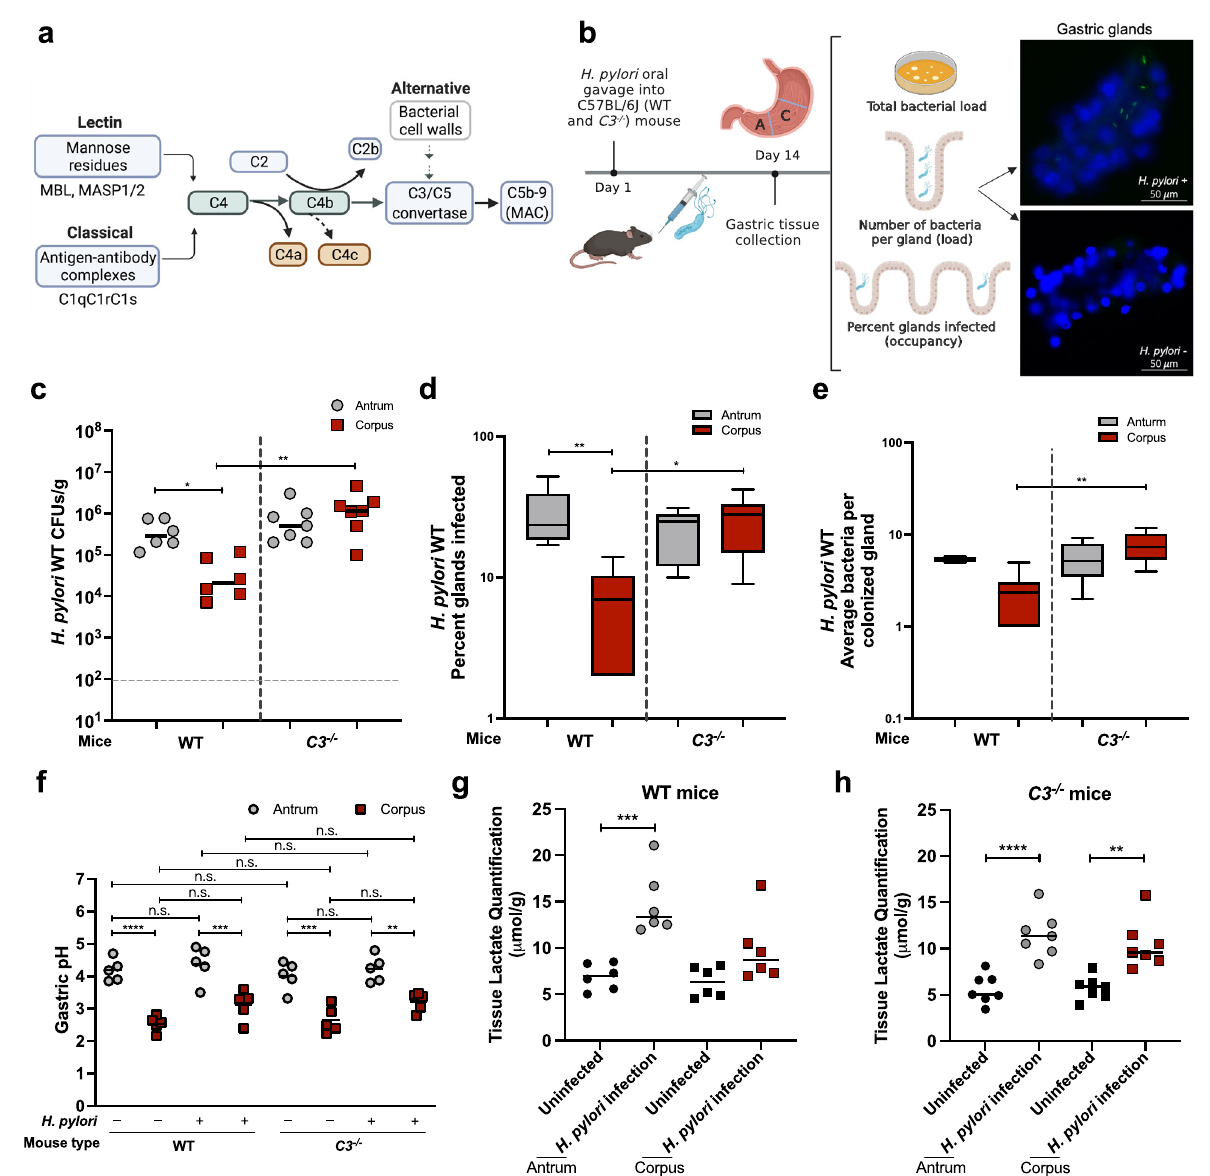
Fig. 1 | Complement plays a vital role in restricting H. pylori gastric coloniza- tion. a Schematic diagram of complement pathways activation. b Schematic illustration of mouse infection analysis. C57BL/6J WT ( n =6) or C3 − / − ( n =7) mice were infected by oral gavage with GFP + H. pylori PMSS1 for two weeks. Stomachs wereisolatedfrominfectedmiceandseparatedintocorpusandantrumpiecesand processed to obtain the total bacterial numbers (colony forming units, CFUs) by plating,toenumeratebacteriainglandsusingmicroscopy.Bacteriawerevisualized by GFP expression (green), while gland cells were visualized using a DNA Hoechst stain(blue). c Totalbacterialnumberfromgastricantrum(gray)andcorpus(red)of infected WT or C3 − / − mice normalized to tissue weight (CFUs/g). Gray dotted line, limit of detection. d Percentage of glands occupied by H. pylori in the gastric antrum (gray) and corpus (red) of infected WT or C3 − / − mice, determined by